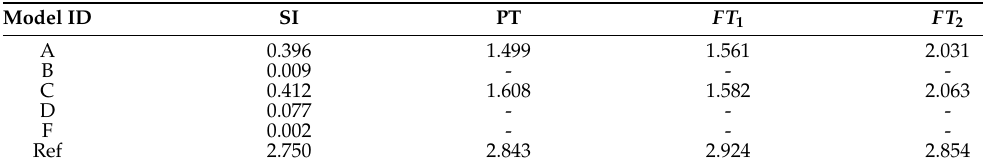
Table 7. Computational time 1 (in s) under different background